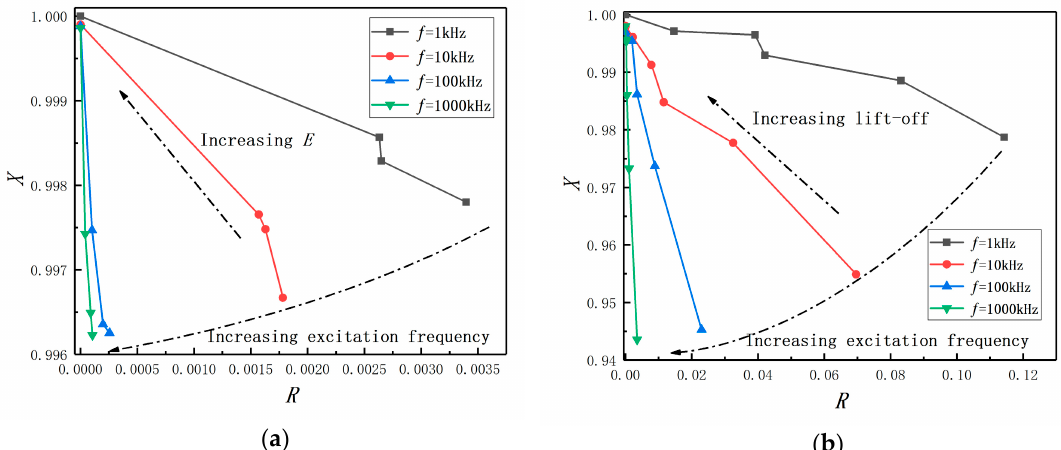
Figure 13. The normalized impedance plane under condition of ( a ) varying eccentricity; ( b ) varying lift-off.